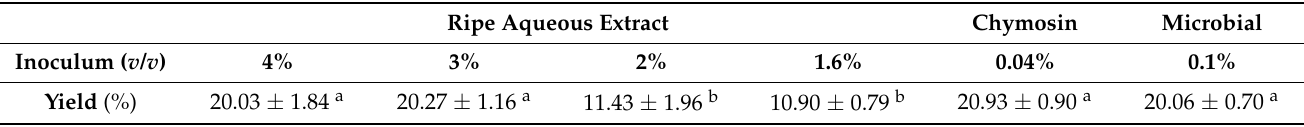
Table 3. Comparison between yield of curds obtained with chymosin, microbial coagulant, and different aliquots of aqueous extract from ripe